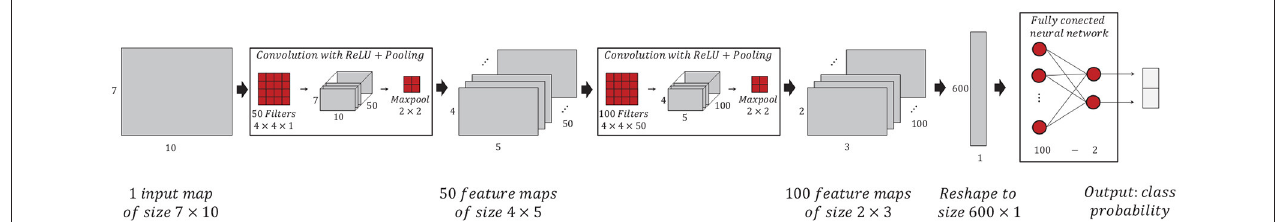
FIGURE 4 | Illustration of the CNN algorithm implemented to discriminate between emergency braking intention from normal driving. The CNN consists of two pairs of convolution and pooling layers followed by a feed forward ANN.